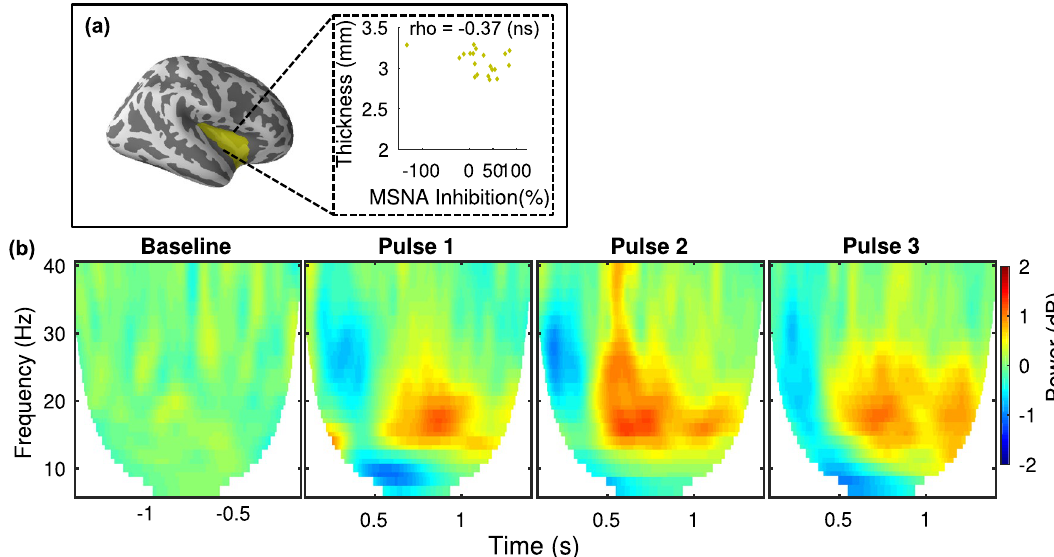
Figure 3. MEG neural oscillatory response and cortical thickness in the Insula. All power is relative to pre- stimulus baseline (n = 20). (a) (left) Insula ROI, (right) correlation between cortical thickness and